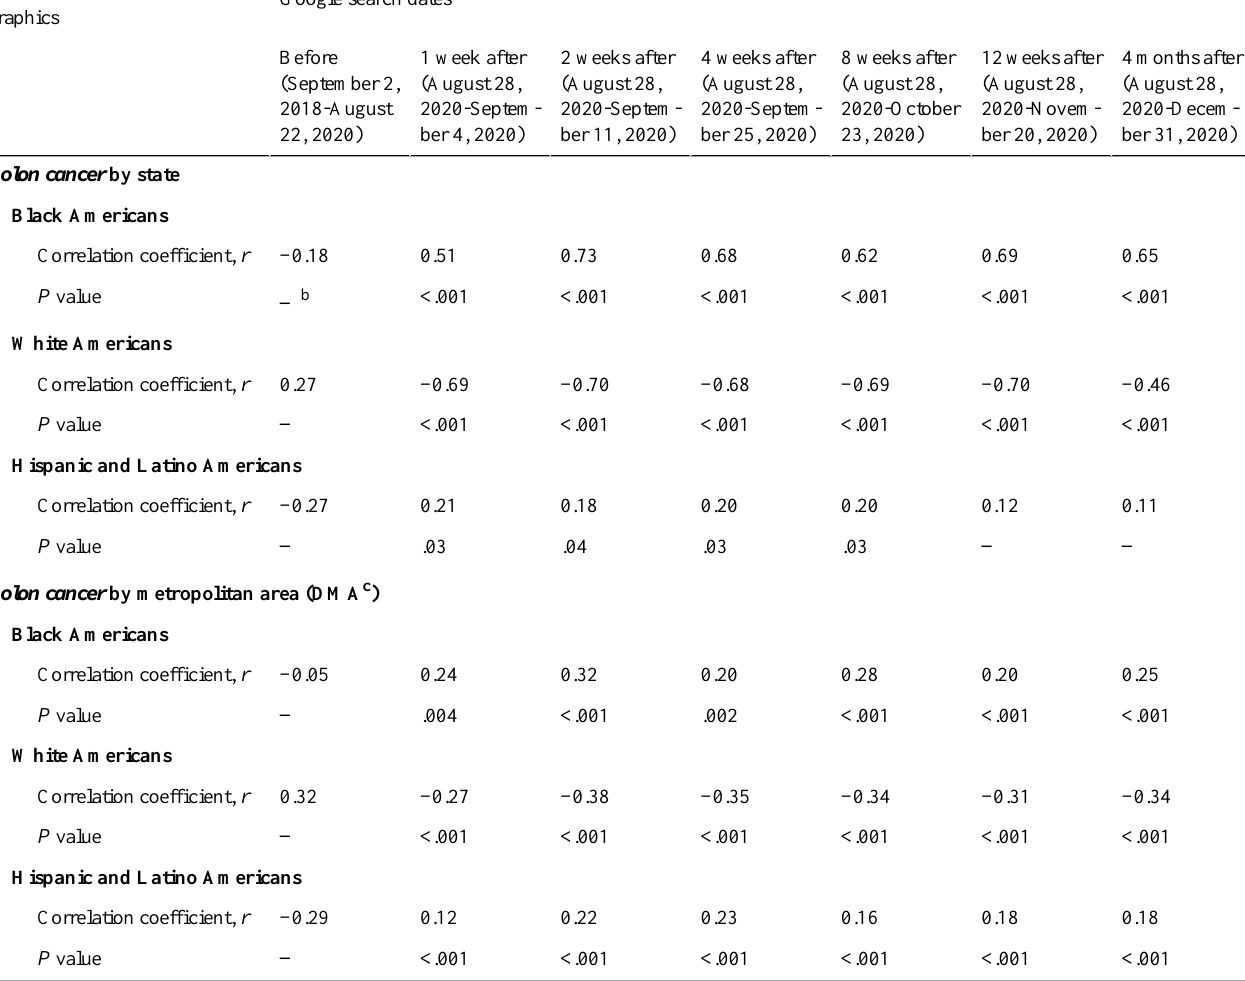
Google search dates a Search terms and racial demo-